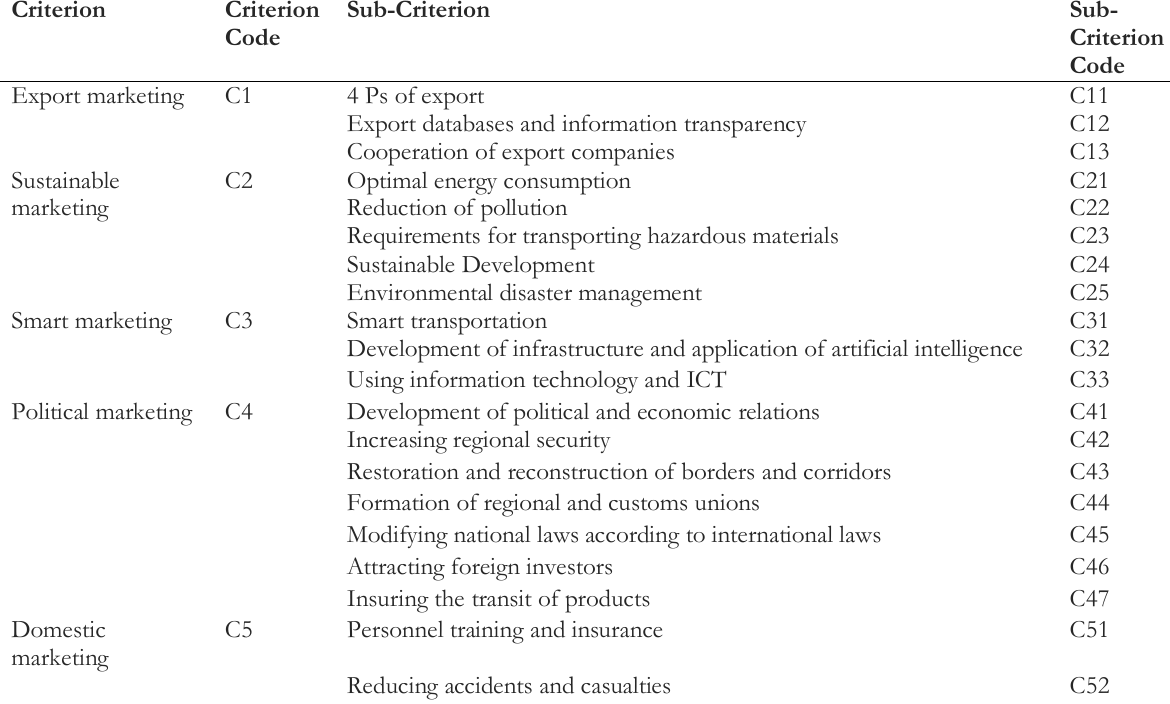
Table 1. Introduction of research